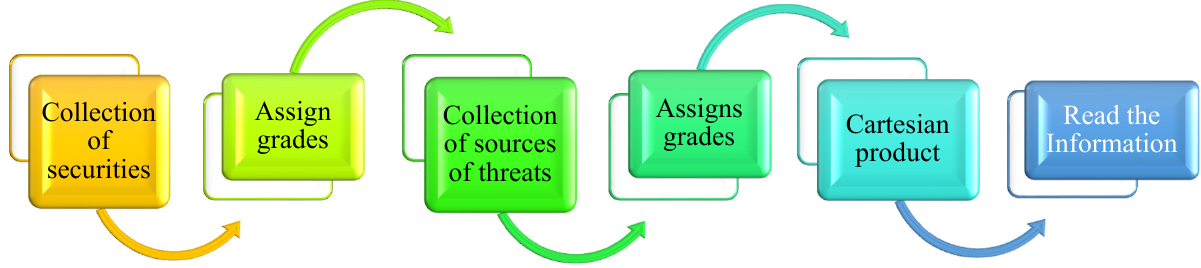
Figure 4. Flowchart for the process being followed.